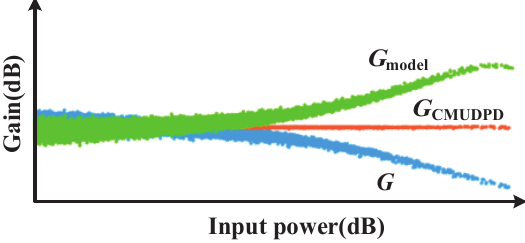
Figure 6. The gain compensation of CMUDPD. The output PSDs of all operation modes obtained by ADS simulations are shown in Figure 7 (i.e., a1 W/O DPD, a2 W/O DPD, a3 W/O DPD, b1 W/O DPD, b2 W/O DPD, and b3 W/O DPD). For comparison, Figure 7 also depicts the output PSDs of all nonlinear models calculated by MATLAB (a1 model, a2 model, a3 model, b1 model, b2 model, and b3 model). It can be seen that different operation modes for each group (i.e., modes a1, a2, and a3 for Group A; and modes b1, b2, and b3 for Group B) exhibit insignificant PSD differences. Thereby, the parameter ε defined in (18) can be utilized to identify the degree of similarity in terms of nonlinearities among different operation modes.